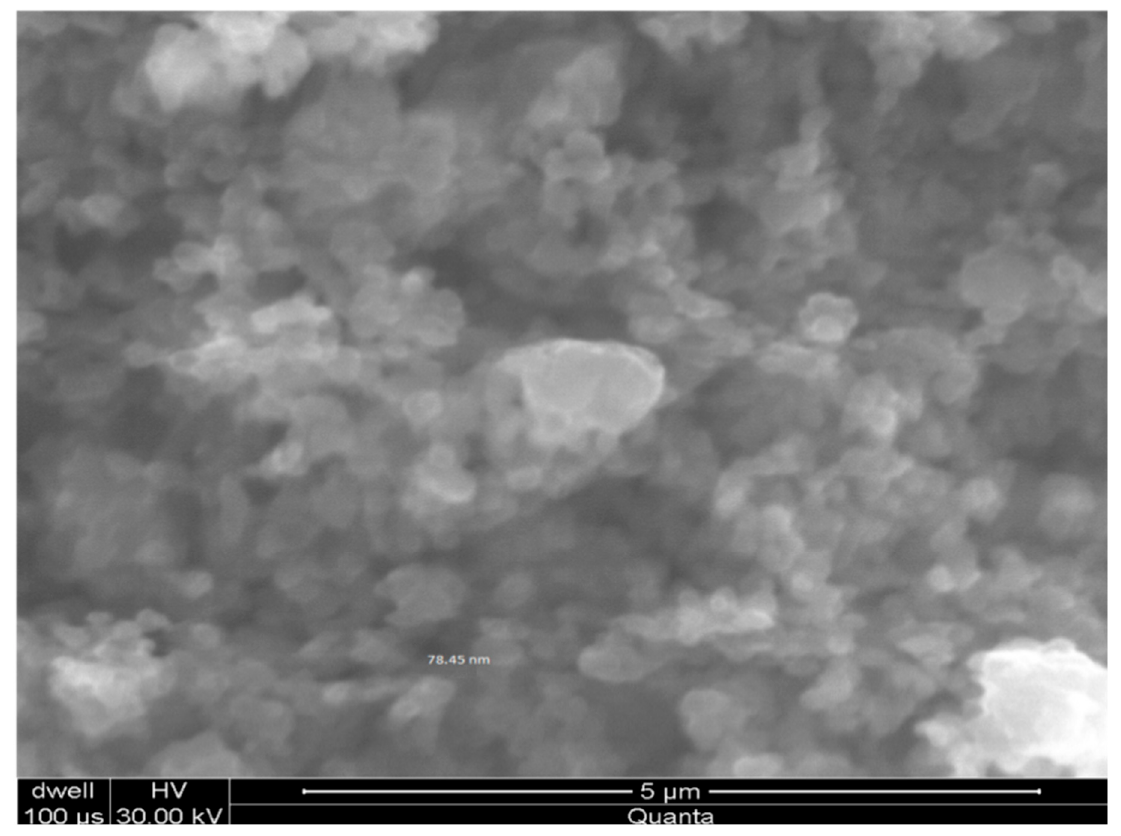
Figure 2. Photomicrograph of SEM analysis of Cu-NPs.